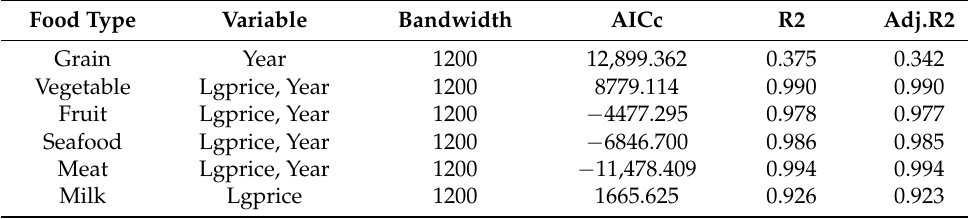
Table 3. Results of geographically weighted regression